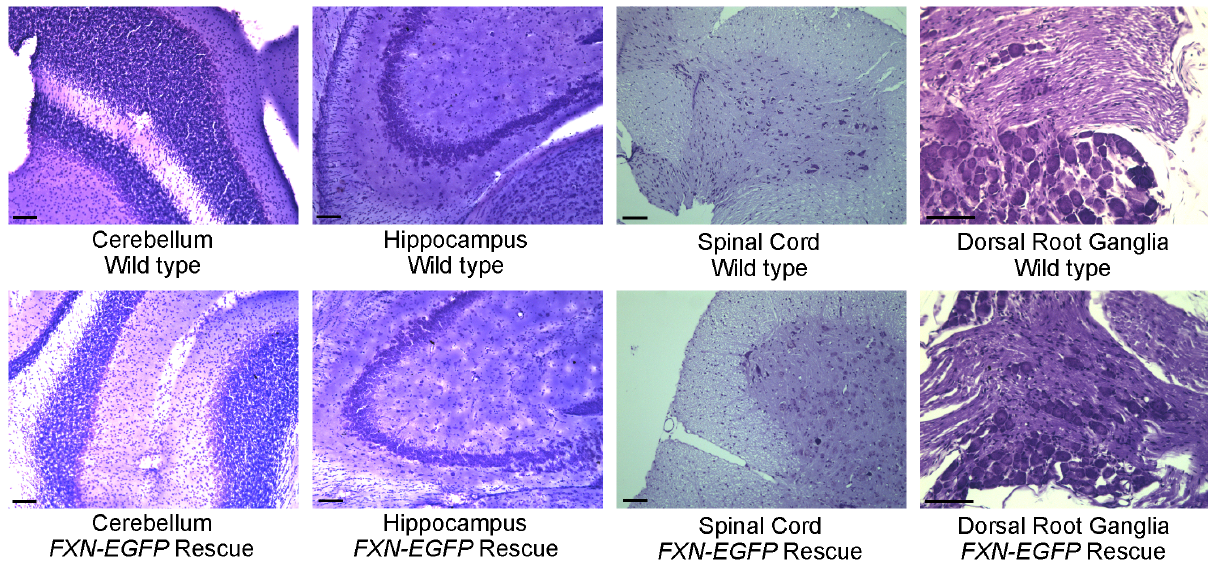
Figure 5. Histology. Cerebellum, hippocampus, spinal cord and dorsal root ganglia tissue samples were collected from 12 month old mice and fixed, sectioned and stained with haematoxylin and eosin. Images are representative of wild type (top row) and FXN-EGFP rescue mice ( FXN-EGFP + , Fxn 2 / 2 ) (bottom row). Bar in lower left of each image corresponds to 100 m m. mouse immunoglobulin and mouse anti-rabbit immunoglobulin